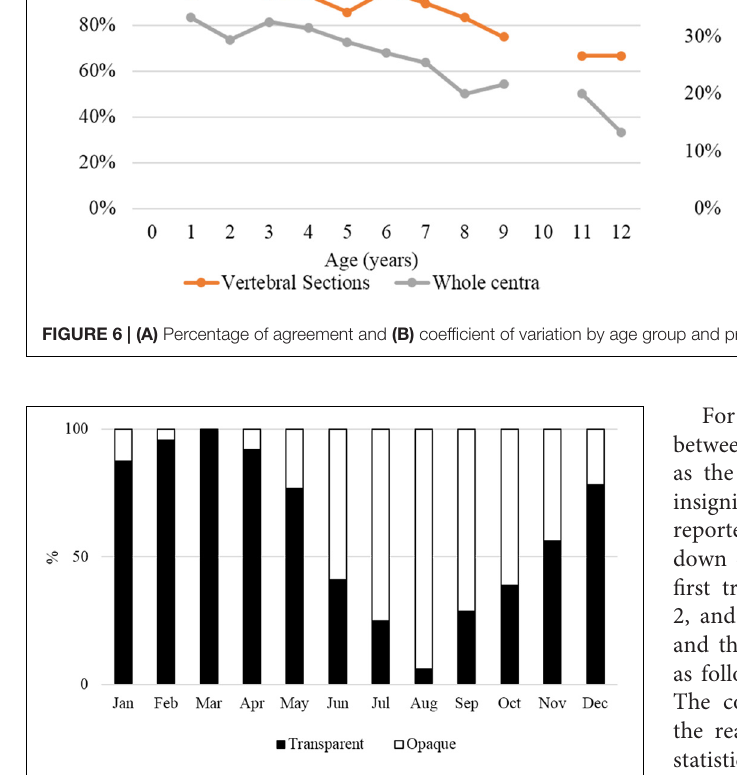
FIGURE 7 | Percentages of monthly opaque and transparent margins of thin vertebral sections.